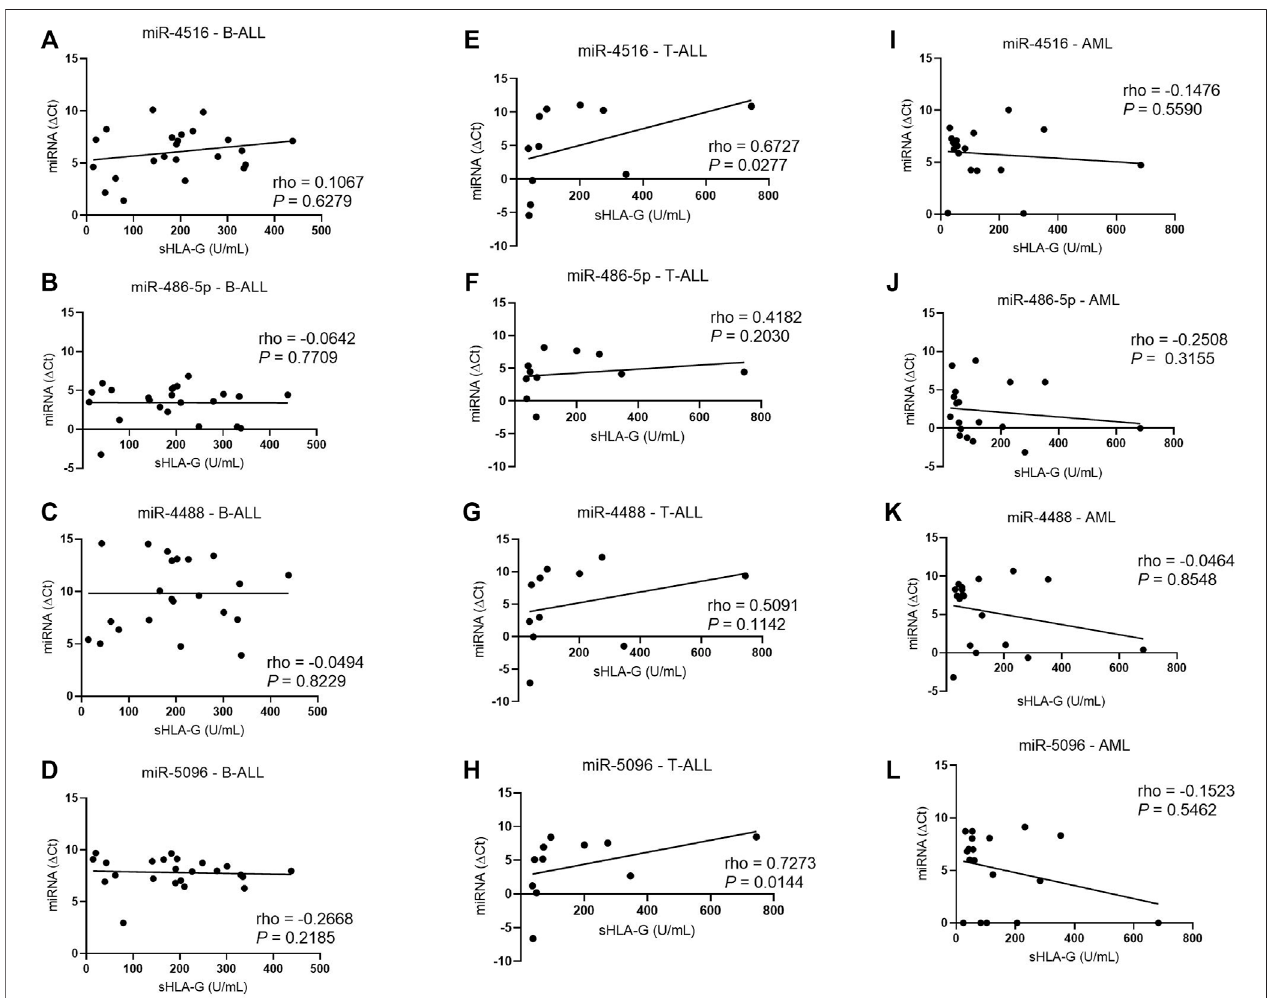
FIGURE 7 | Correlation coef fi cient analysis between miRNAs expression and sHLA-G levels in the bone marrow from patients with untreated leukemia. (A) Correlationbetweenhsa-miR-4516andsHLA-GinB-ALL( n =23); (B) correlationbetweenhsa-miR-486-5pandsHLA-GinB-ALL( n =23); (C) correlationbetweenhsa- miR-4488 and sHLA-G in B-ALL ( n = 23); (D) correlation between hsa-miR-5096 and sHLA-G in B-ALL ( n = 23); (E) correlation between hsa-miR-4516 and sHLA-G in T-ALL ( n = 11); (F) correlation between hsa-miR-486-5p and sHLA-G in T-ALL ( n = 11); (G) correlation between hsa-miR-4488 and sHLA-G in T-ALL ( n = 11); (H) correlationbetweenhsa-miR-5096 and sHLA-Gin T-ALL ( n = 11); (I) correlation between hsa-miR-4516 and sHLA-GinAML ( n =18); (J) correlation between hsa-miR- 486-5p and sHLA-G in AML ( n = 18); (K) correlation between hsa-miR-4488 and sHLA-G in AML ( n = 18); and (L) correlation between hsa-miR-5096 and sHLA-G in AML ( n = 18). For the correlation analysis, the Spearman ’ s correlation coef fi cient was